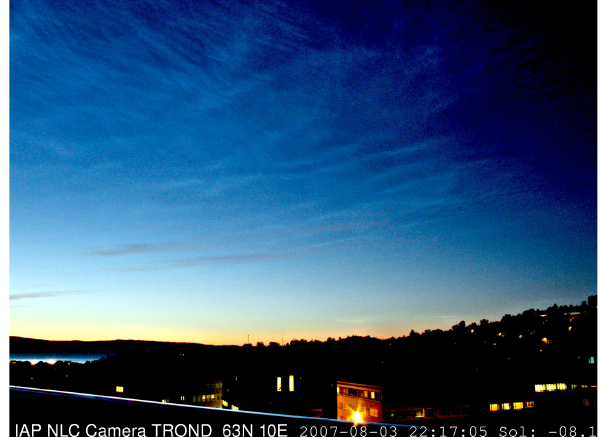
Fig. 7. Noctilucent cloud observed by camera from Trondheim on 3 August 2007 22:17UT during the AIM overpass. To emphasize the cloud structures the raw image was processed by a 50 point unsharp- mask of weight 0.8.